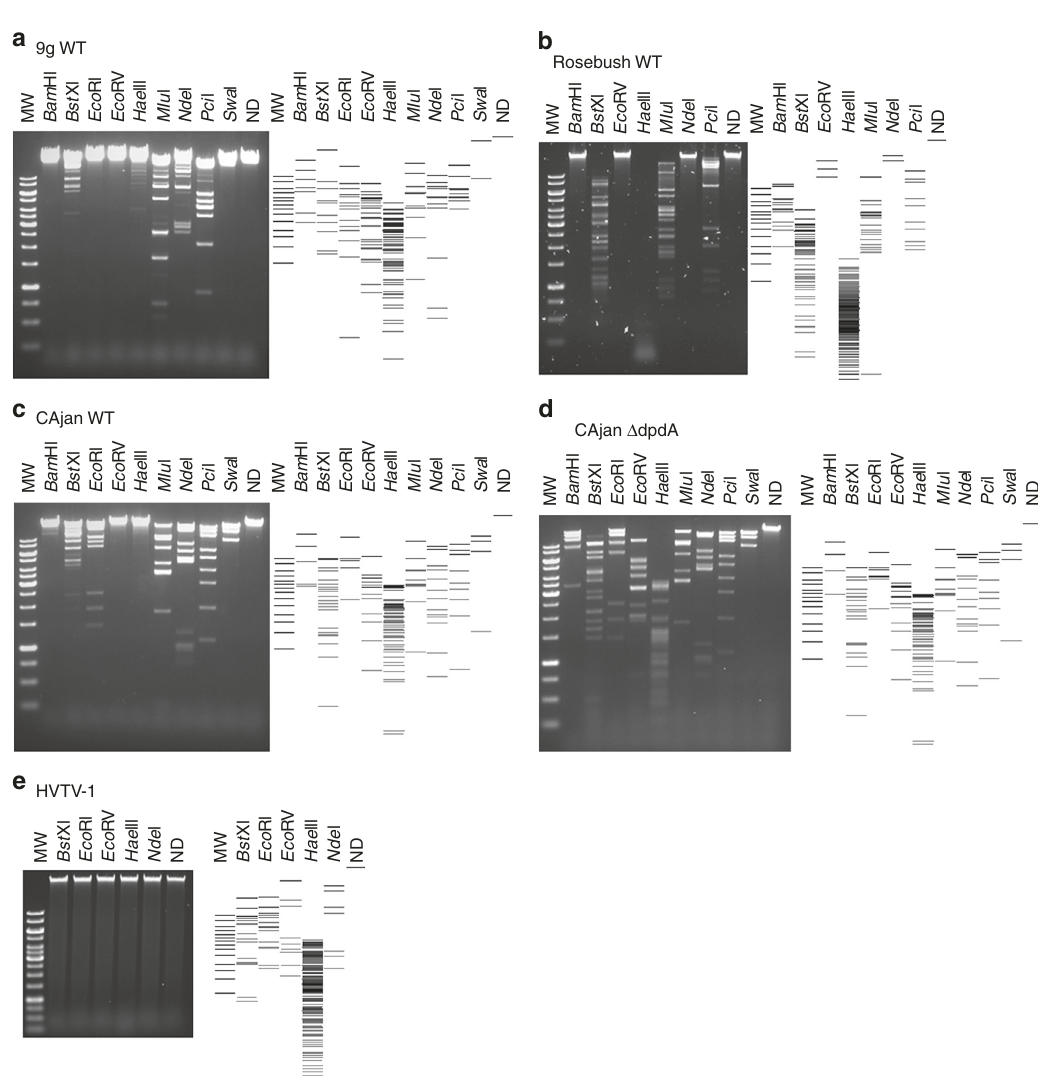
Fig. 5 Restriction patterns for phage genomic DNA. Different restriction enzymes were used on the DNA of Enterobacteria phage 9g ( a ), Mycobacterium phage Rosebush ( b ), Escherichia phage CAjan WT ( c ), Escherichia phage CAjan Δ dpdA ( d ), and Halovirus HVTV-1 ( e ). On the side of each gel is the representation of the expected restriction pattern. Source data are provided as a Source Data fi